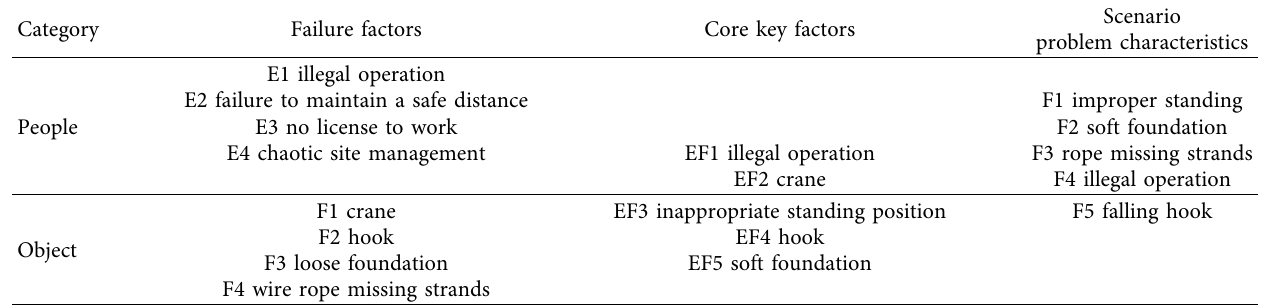
Table 3: Lifting injury unsafe scenario features.